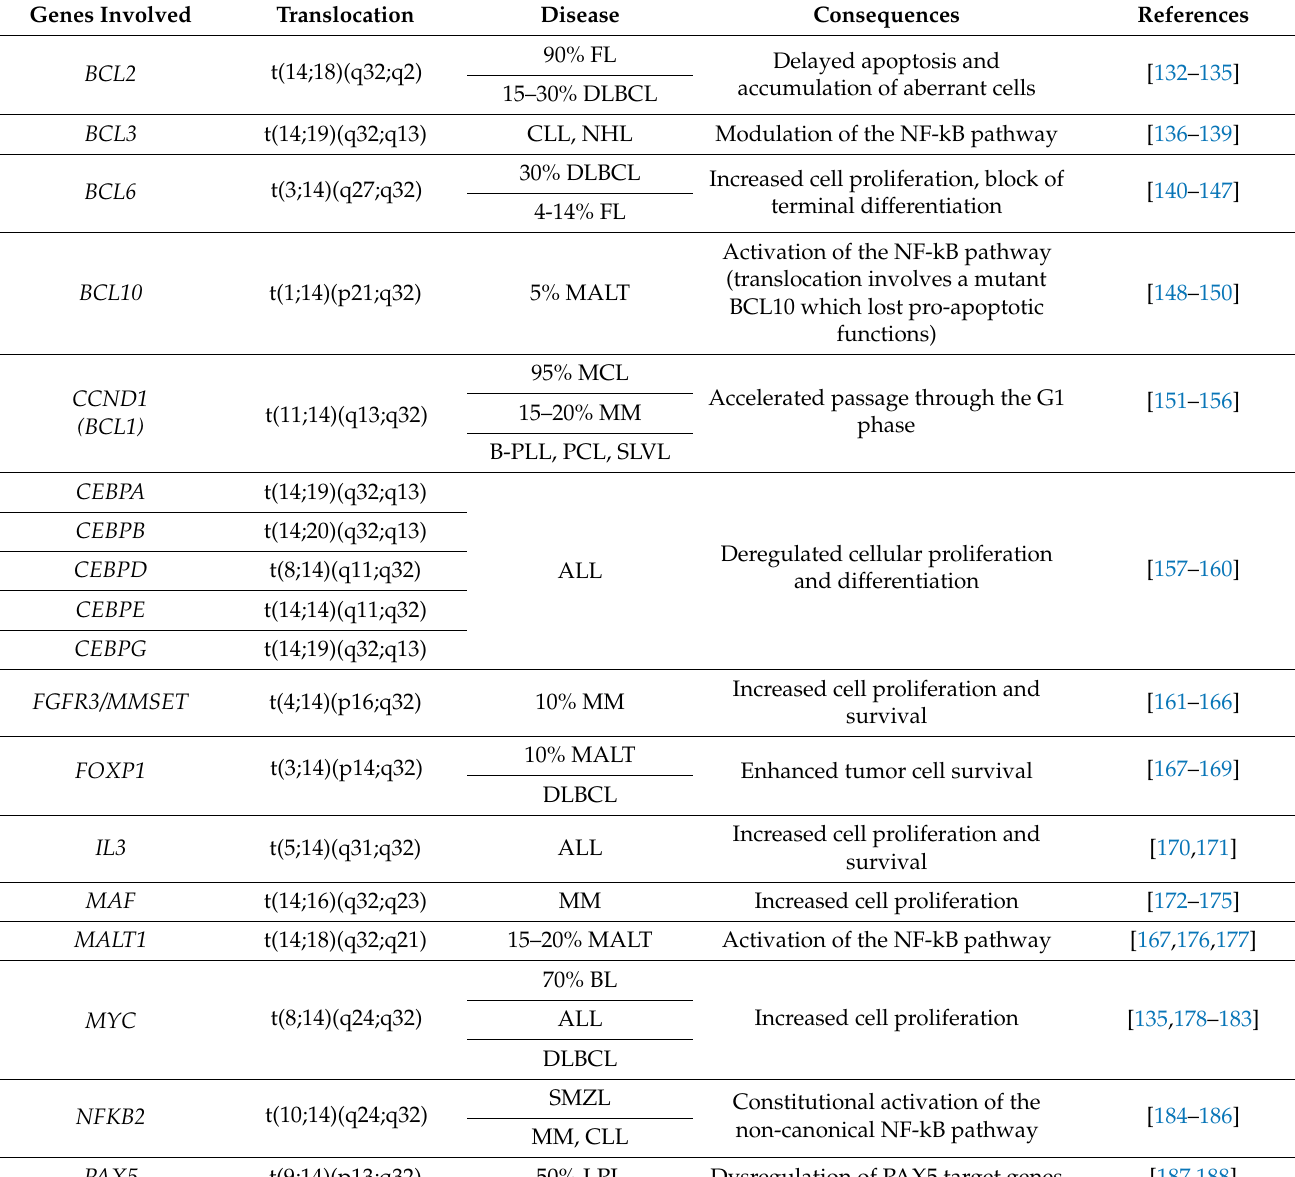
Table 1. Translocations involving immunoglobulin heavy chain locus in B-cell malignancies. Genes